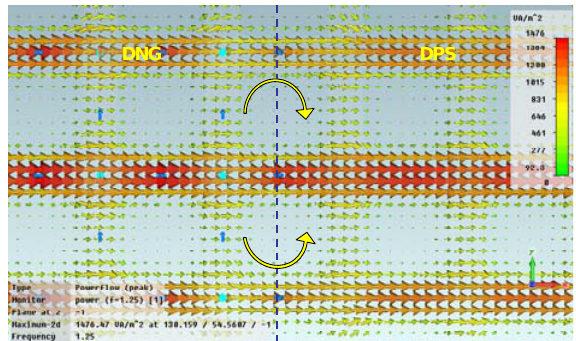
(b) Vortexlike power flow at the DNG/DPS interfaces in 1.25GHz near the interface in Ⅱ Figure 1. DPSDPS DPSDPS